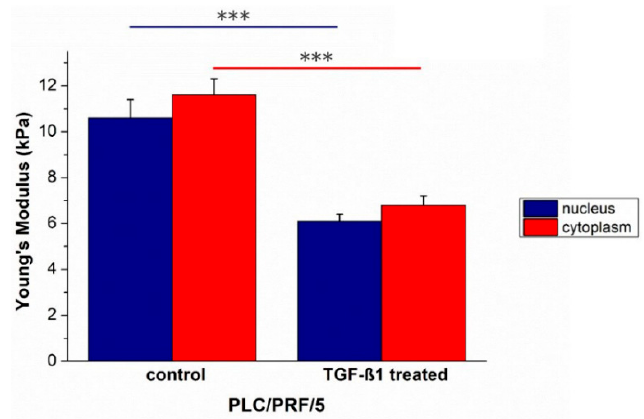
Figure 4. The Young’s modulus values with standard deviation, calculated from the nuclear region and the cytoskeletal area respectively, were reported for untreated PLC/PRF/5 CTR and TGF- β 1 treated PLC/PRF/5 TGF- β 1 cells. Results were statistically significant for p < 0.005 (indicated as ***).